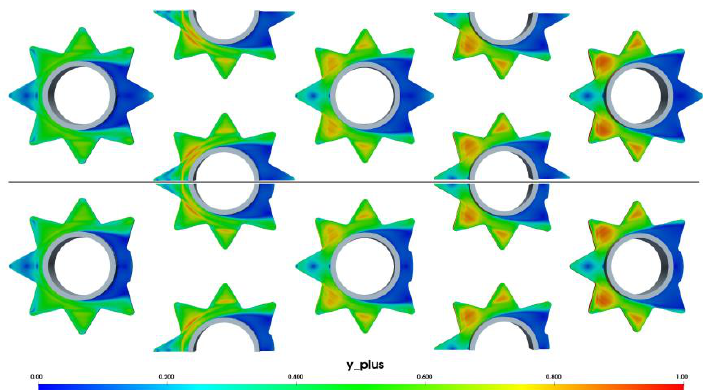
Figure 10. The y + fields for star-shaped fins and trimmed fins.